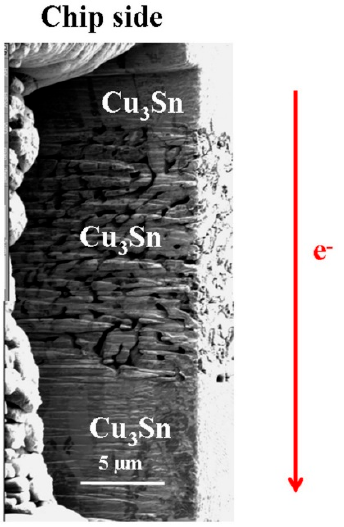
Figure 5. Cross-sectional FIB image of Cu 3 Sn IMC structures.